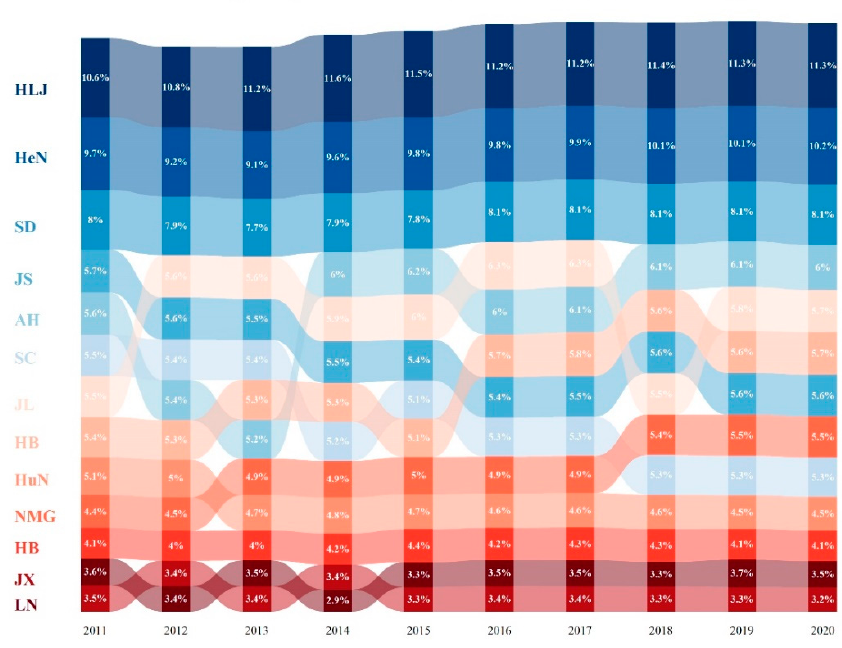
Figure 2. The share of grain production to total national production during 2011–2020.